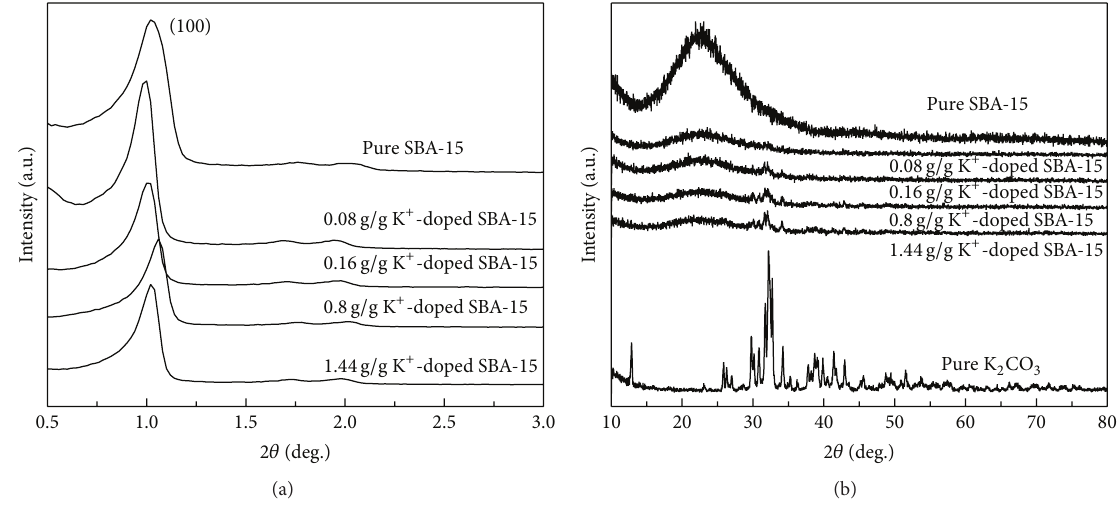
Figure 2: Lower angle (a) and wide angle (b) XRD spectra of the materials.